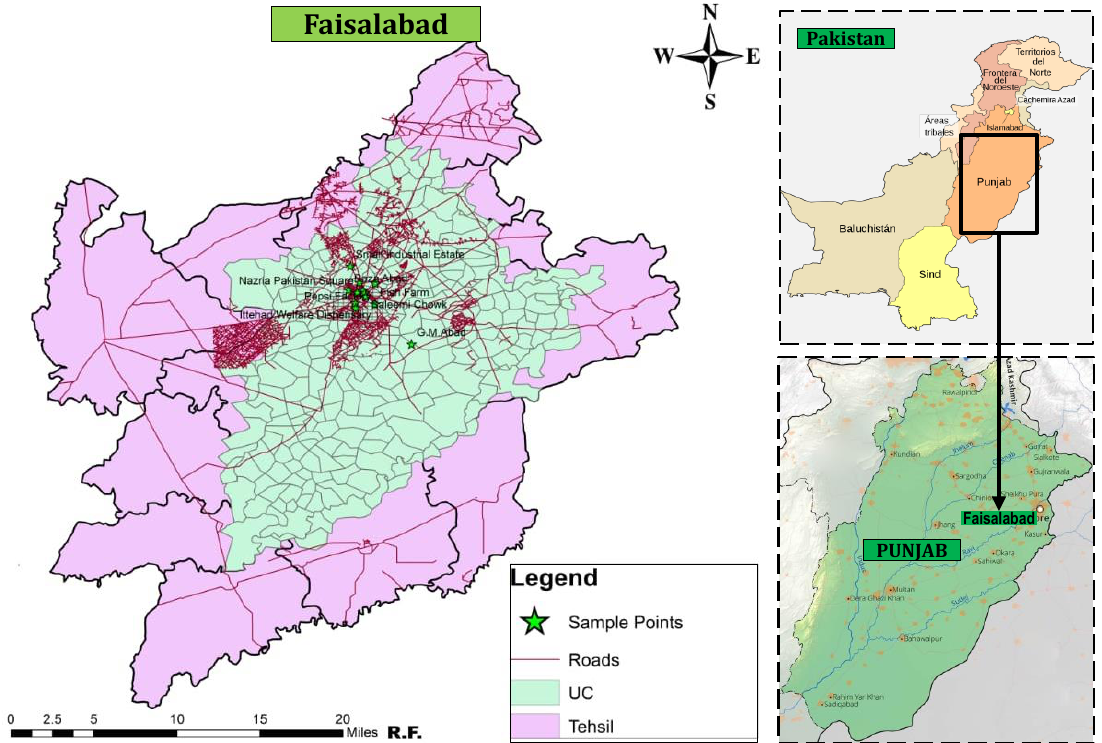
Figure 1. Study sites within the Faisalabad city and location of the city within the political map of Pakistan.